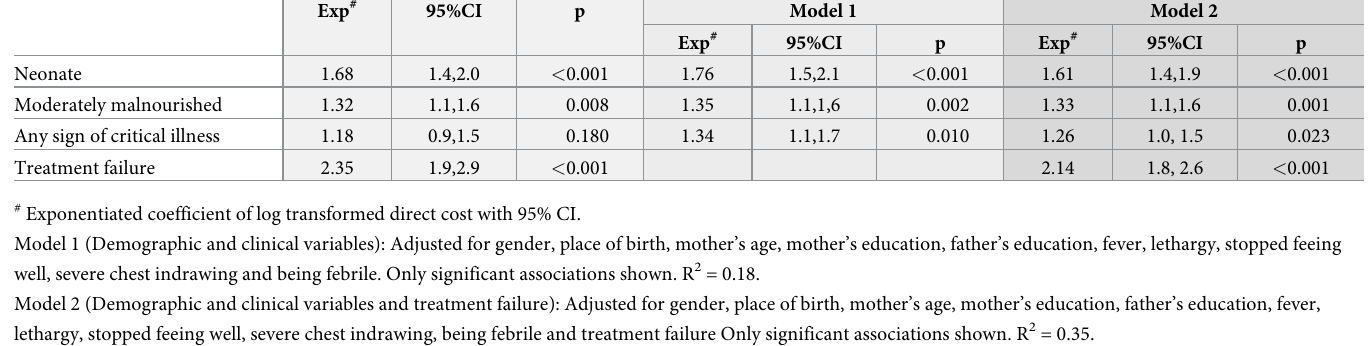
Table 3. Determinants of direct cost of treatment for clinical severe infection in Nepali infants aged 3–59 days (N = 206).